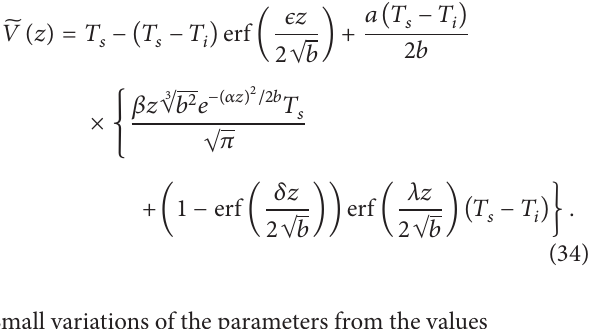
and numerical solution 𝑉 Initial